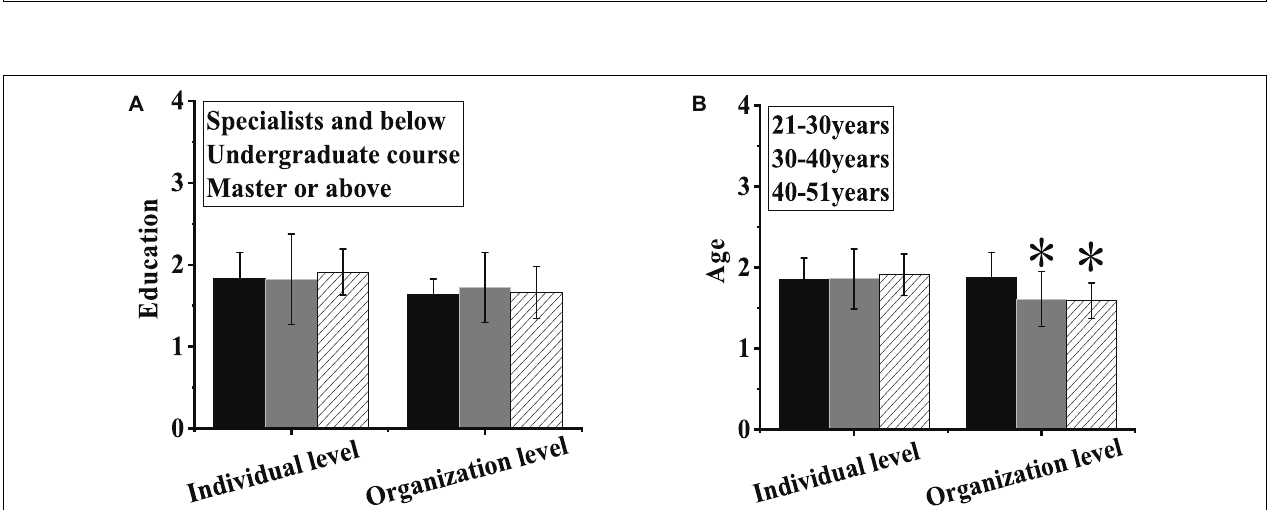
FIGURE 4 | Differences in coping strategies under stress between subjects of different educational backgrounds (A) and ages (B) . ∗ Indicated that compared with those between 21 and 30 years old, the difference was notable ( P < 0.05).